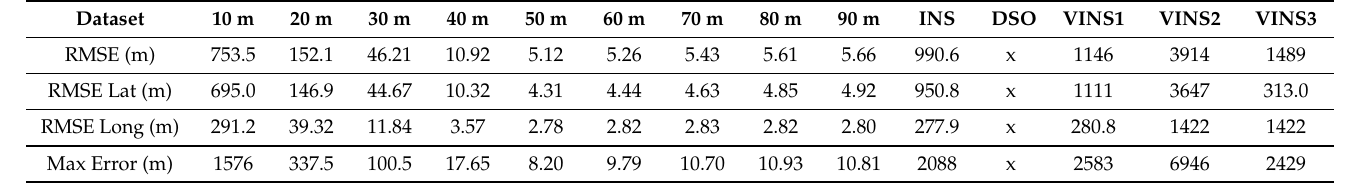
Table 4. Scenario 4 Localization Results (Trajectory Length: 5290